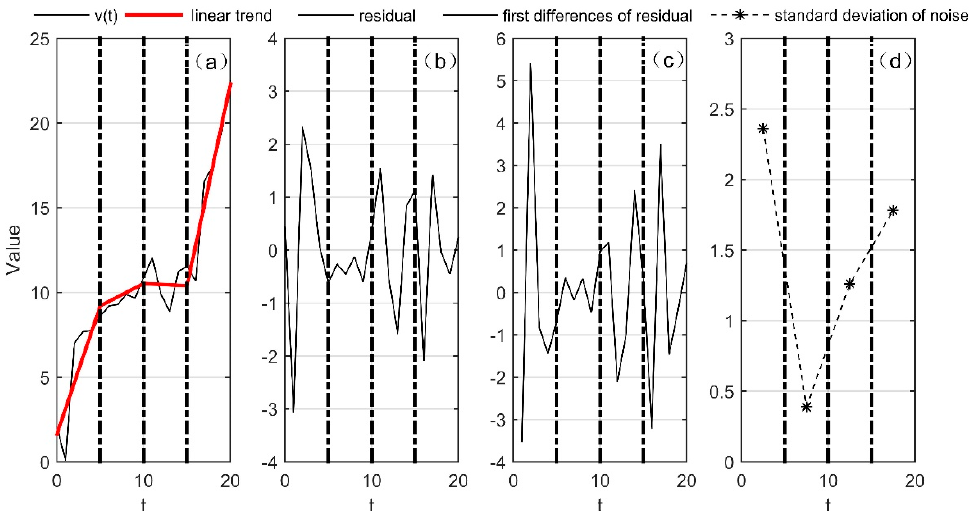
Figure 2. The specific steps of estimating the noise standard deviation.